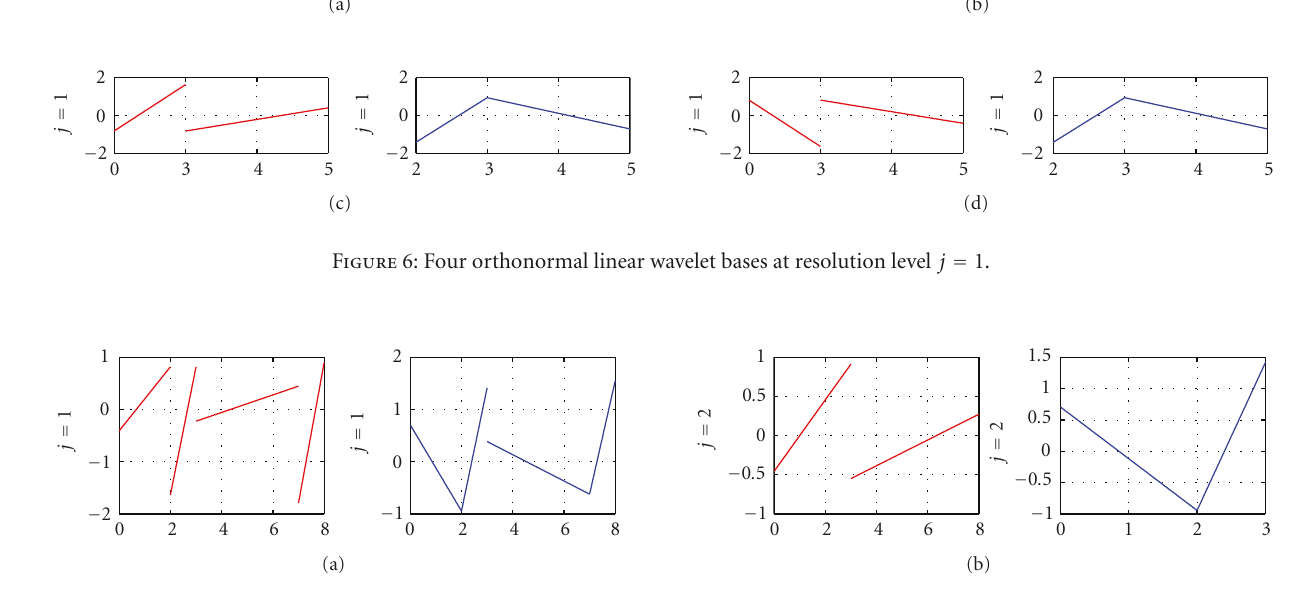
Figure 7: Linear wavelet functions at resolution levels j = 1,2.